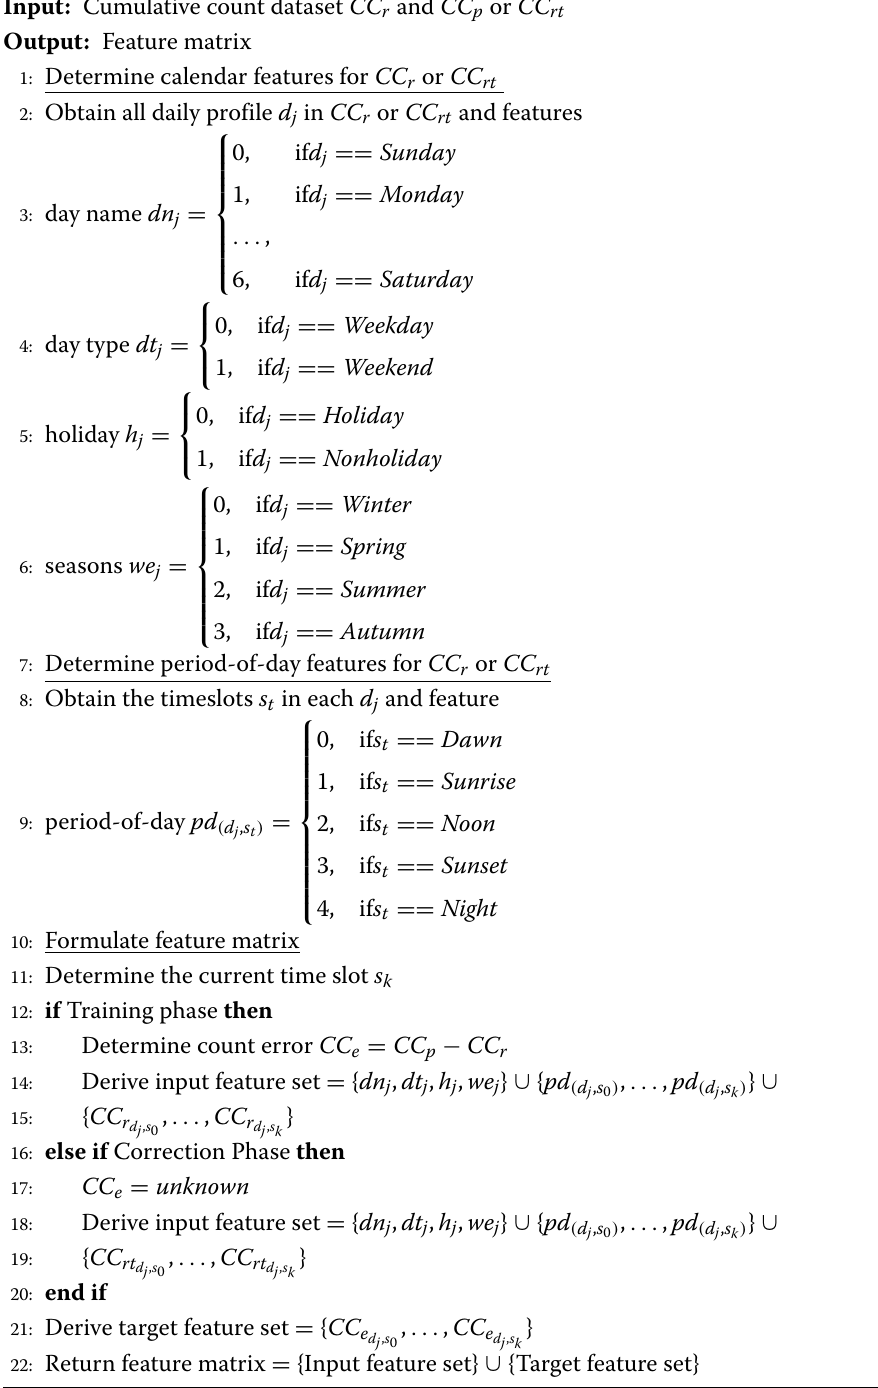
Algorithm 1 PreCount Feature